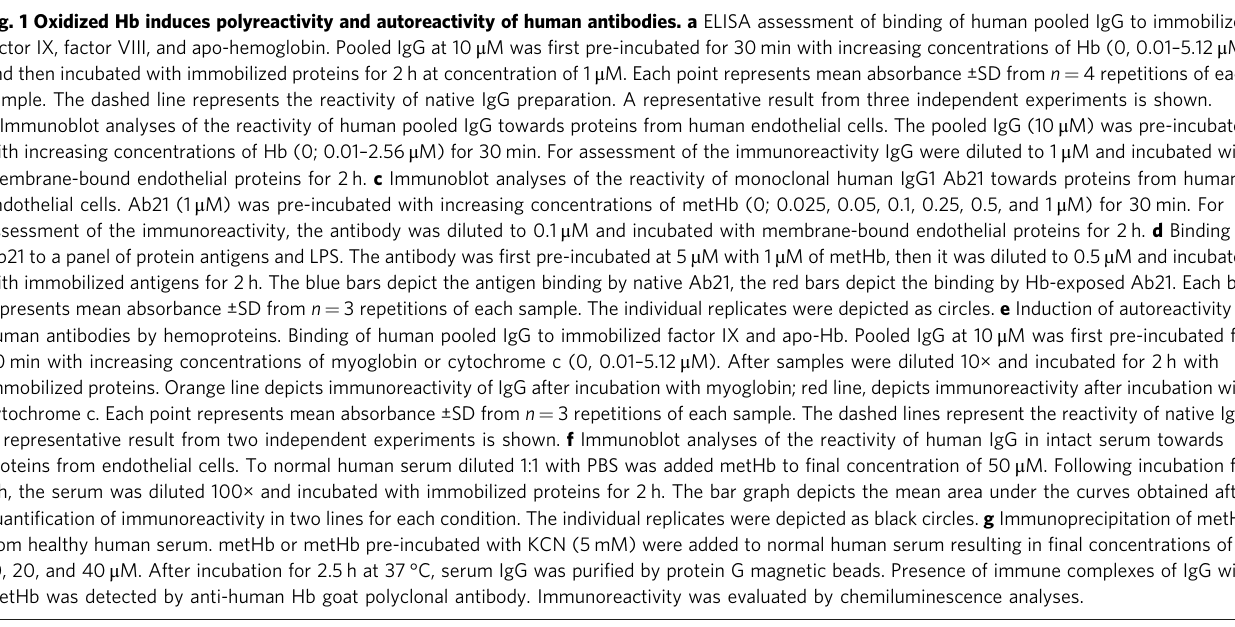
Fig. 1 Oxidized Hb induces polyreactivity and autoreactivity of human antibodies. a ELISA assessment of binding of human pooled IgG to immobilized factor IX, factor VIII, and apo-hemoglobin. Pooled IgG at 10 μ M was fi rst pre-incubated for 30 min with increasing concentrations of Hb (0, 0.01 – 5.12 μ M) and then incubated with immobilized proteins for 2 h at concentration of 1 μ M. Each point represents mean absorbance ±SD from n = 4 repetitions of each sample. The dashed line represents the reactivity of native IgG preparation. A representative result from three independent experiments is shown. b Immunoblot analyses of the reactivity of human pooled IgG towards proteins from human endothelial cells. The pooled IgG (10 μ M) was pre-incubated with increasing concentrations of Hb (0; 0.01 – 2.56 μ M) for 30 min. For assessment of the immunoreactivity IgG were diluted to 1 μ M and incubated with membrane-bound endothelial proteins for 2 h. c Immunoblot analyses of the reactivity of monoclonal human IgG1 Ab21 towards proteins from human endothelial cells. Ab21 (1 μ M) was pre-incubated with increasing concentrations of metHb (0; 0.025, 0.05, 0.1, 0.25, 0.5, and 1 μ M) for 30 min. For assessment of the immunoreactivity, the antibody was diluted to 0.1 μ M and incubated with membrane-bound endothelial proteins for 2 h. d Binding of Ab21 to a panel of protein antigens and LPS. The antibody was fi rst pre-incubated at 5 µ M with 1 µ M of metHb, then it was diluted to 0.5 µ M and incubated with immobilized antigens for 2 h. The blue bars depict the antigen binding by native Ab21, the red bars depict the binding by Hb-exposed Ab21. Each bar represents mean absorbance ±SD from n = 3 repetitions of each sample. The individual replicates were depicted as circles. e Induction of autoreactivity of human antibodies by hemoproteins. Binding of human pooled IgG to immobilized factor IX and apo-Hb. Pooled IgG at 10 μ M was fi rst pre-incubated for 30 min with increasing concentrations of myoglobin or cytochrome c (0, 0.01 – 5.12 μ M). After samples were diluted 10× and incubated for 2 h with immobilized proteins. Orange line depicts immunoreactivity of IgG after incubation with myoglobin; red line, depicts immunoreactivity after incubation with cytochrome c. Each point represents mean absorbance ±SD from n = 3 repetitions of each sample. The dashed lines represent the reactivity of native IgG. A representative result from two independent experiments is shown. f Immunoblot analyses of the reactivity of human IgG in intact serum towards proteins from endothelial cells. To normal human serum diluted 1:1 with PBS was added metHb to fi nal concentration of 50 μ M. Following incubation for 2 h, the serum was diluted 100× and incubated with immobilized proteins for 2 h. The bar graph depicts the mean area under the curves obtained after quanti fi cation of immunoreactivity in two lines for each condition. The individual replicates were depicted as black circles. g Immunoprecipitation of metHb from healthy human serum. metHb or metHb pre-incubated with KCN (5 mM) were added to normal human serum resulting in fi nal concentrations of 5, 10, 20, and 40 μ M. After incubation for 2.5 h at 37 °C, serum IgG was puri fi ed by protein G magnetic beads. Presence of immune complexes of IgG with metHb was detected by anti-human Hb goat polyclonal antibody. Immunoreactivity was evaluated by chemiluminescence